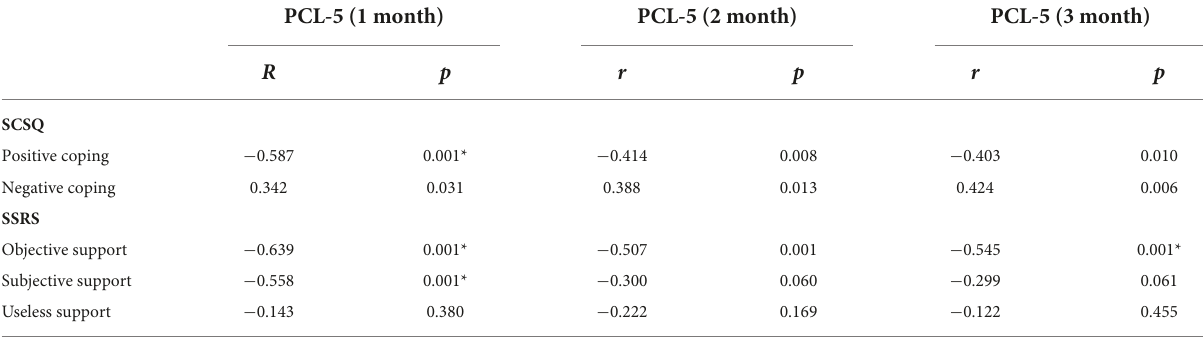
TABLE 4 Correlation between 3 PCL-5 scores and social support, coping style scale